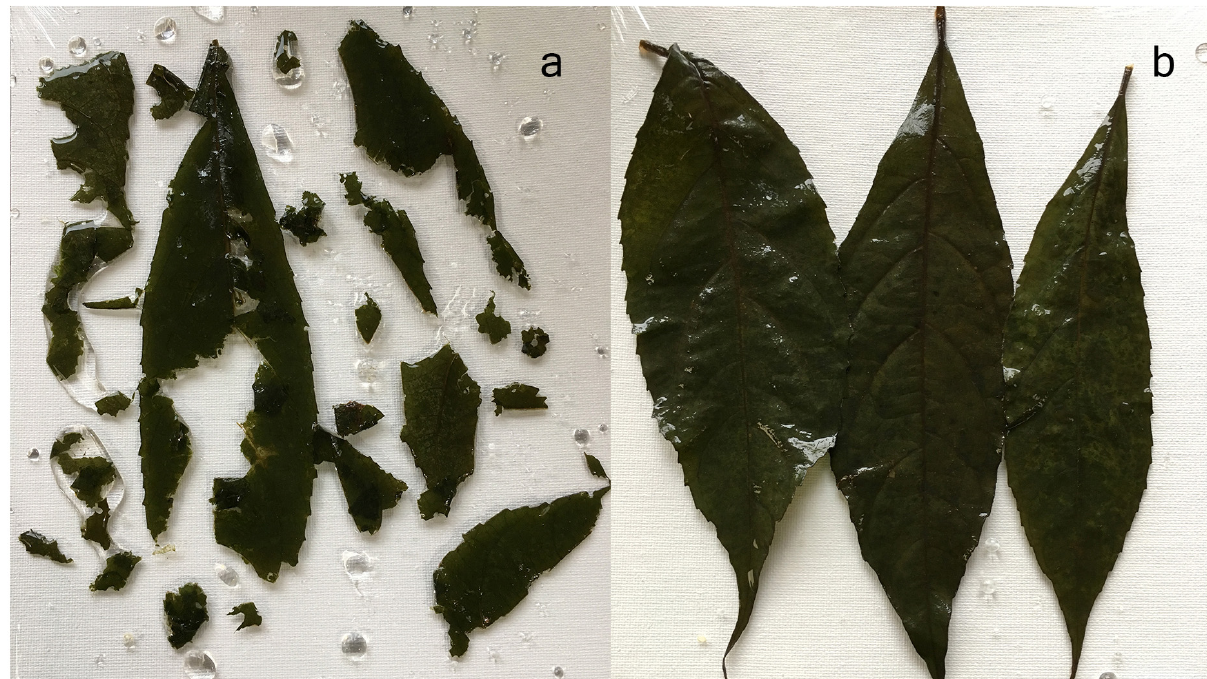
Figure 3. Koanophyllon pittieri leaves in tanks after nine days of incubation: A , Leaves in tanks with crabs ( Ptychophallus tumimanus ); B , Leaves in control tank (no